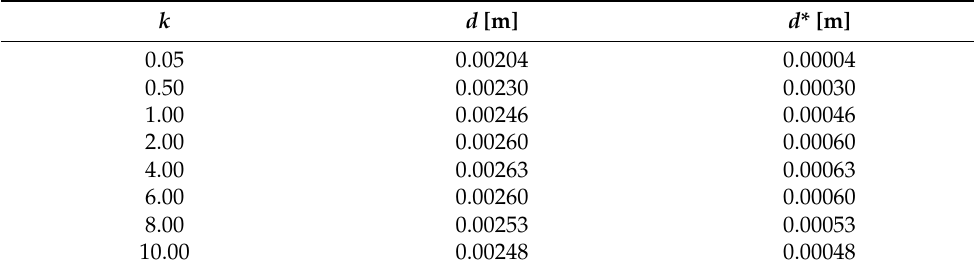
Table 9. Neutral plane positioning parameters.